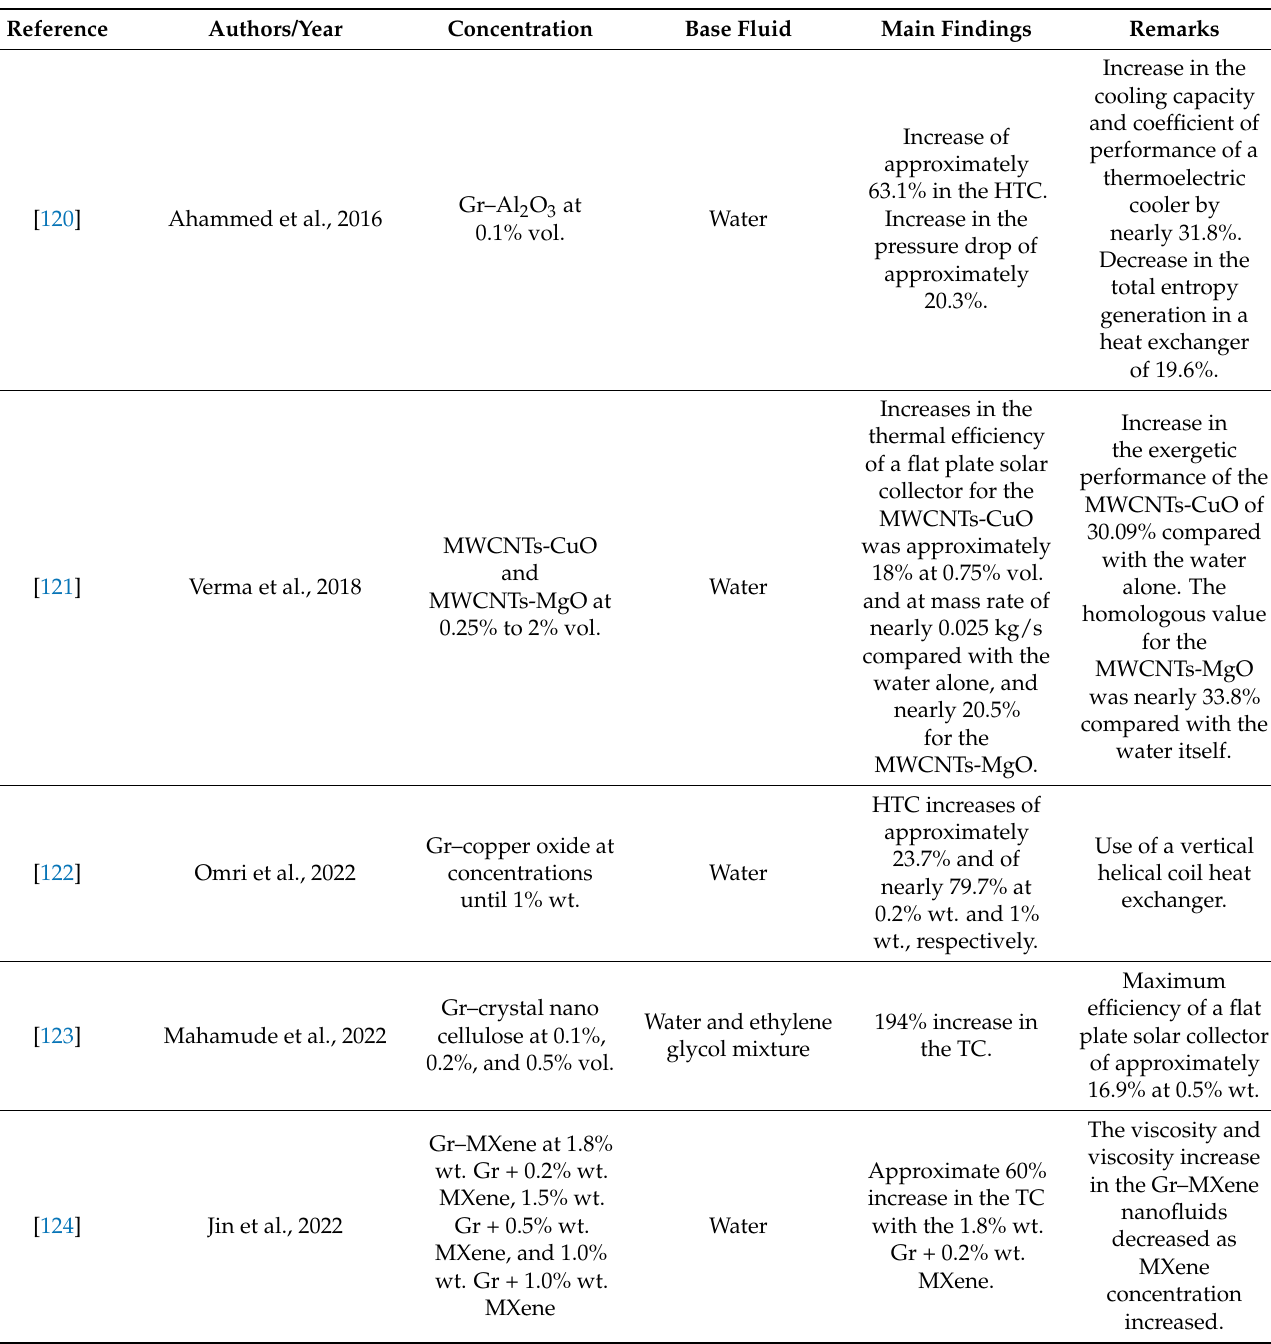
Table 6. Recent experimental works on 2D hybrid